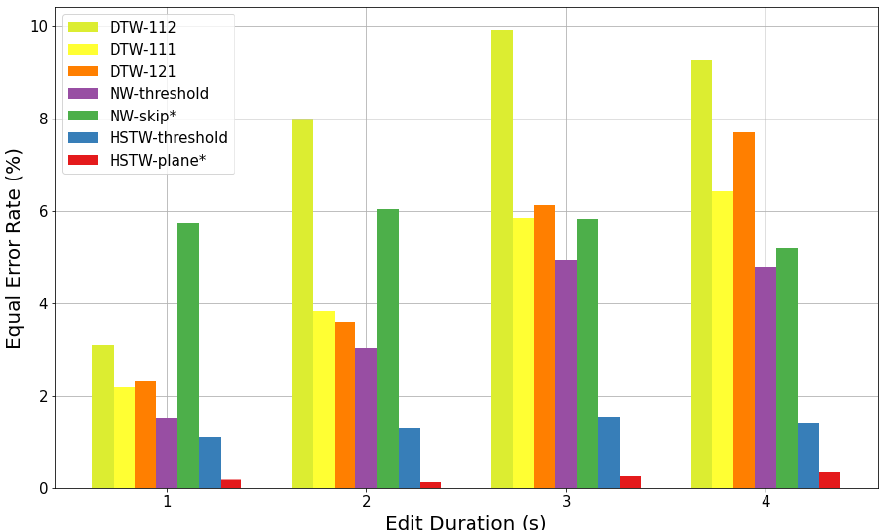
Figure 2. Results on the speech alignment & verification task. Bars indicate the equal error rate for classifying audio frames as matching vs. non-matching. Systems with ∗ are not threshold-based and therefore do not sweep out a full ROC curve. For these systems, the bar indicates the mean values of the false positive and false negative rates.